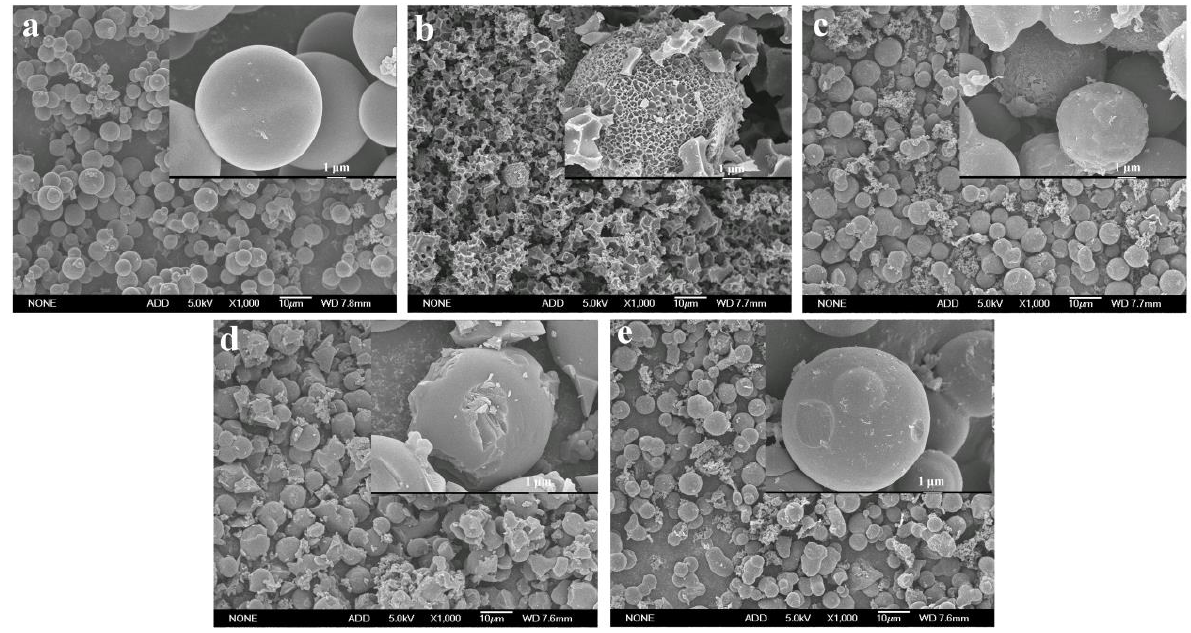
Figure 2. SEM images of ( a ) ACS, ( b ) ACS-KOH, ( c ) ACS-K 2 CO 3 , ( d ) ACS-ZnCl 2 , and ( e ) ACS- Na 2 CO 3 at a magnification of 1000 × and 10,000 × , respectively.